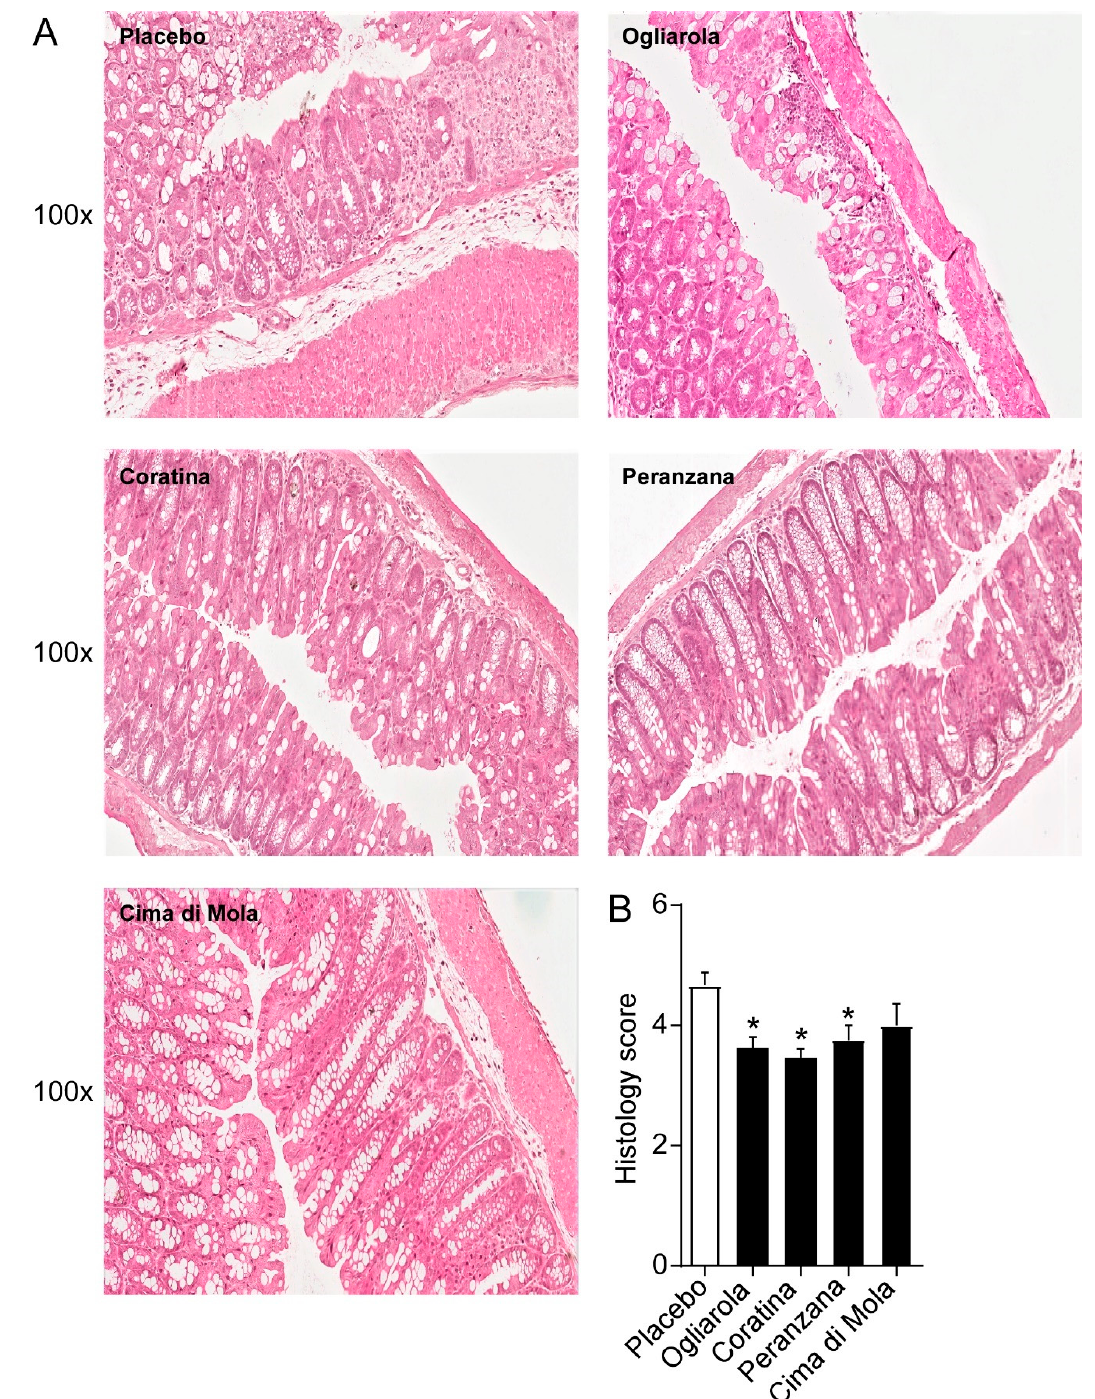
Figure 3. Apulian EVO cultivars treatment improves intestinal morphology in DSS-treated mice. ( A ) Representative H&E-stained colonic sections for Ogliarola, Cima di Mola, Coratina, Peranzana EVOO and placebo treated mice. (100× Magnification) ( B ) Histology score. All values represent means ± SD. Differences between means were tested for significance using 1-way ANOVA followed by the Bonferroni test (* p < 0.05).